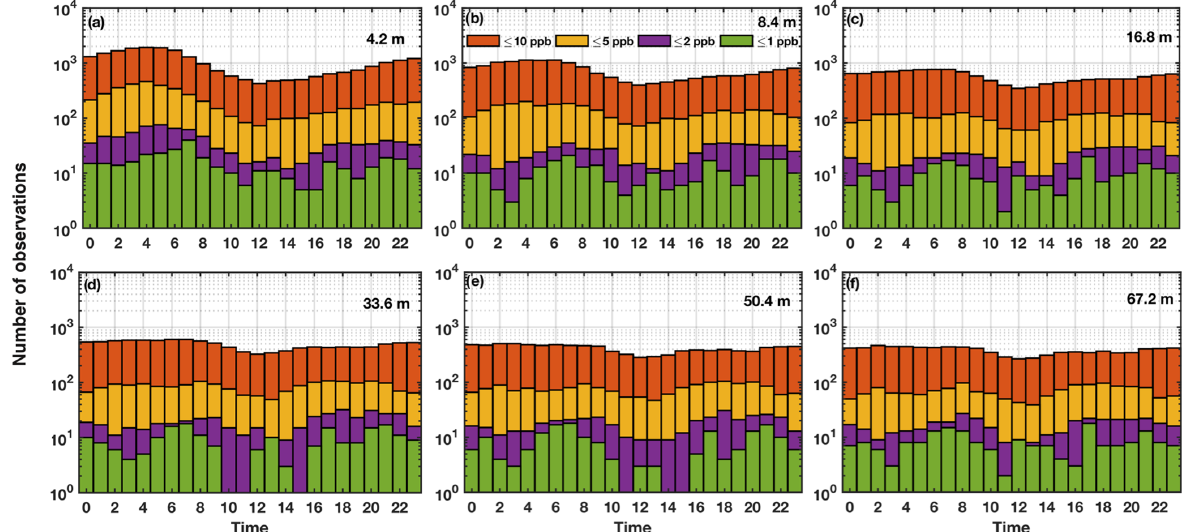
Figure 4. Hourly distribution of observations of ozone concentration drops below 10, 5, 2, and 1ppb at different heights: (a) 4.2m, (b) 8.4m, (c) 16.8 m, (d) 33.6m, (e) 50.4m, and (f) 67.2m. The statistics were based on the 10min ozone data and the observation frequency is presented in the logarithmic scale.